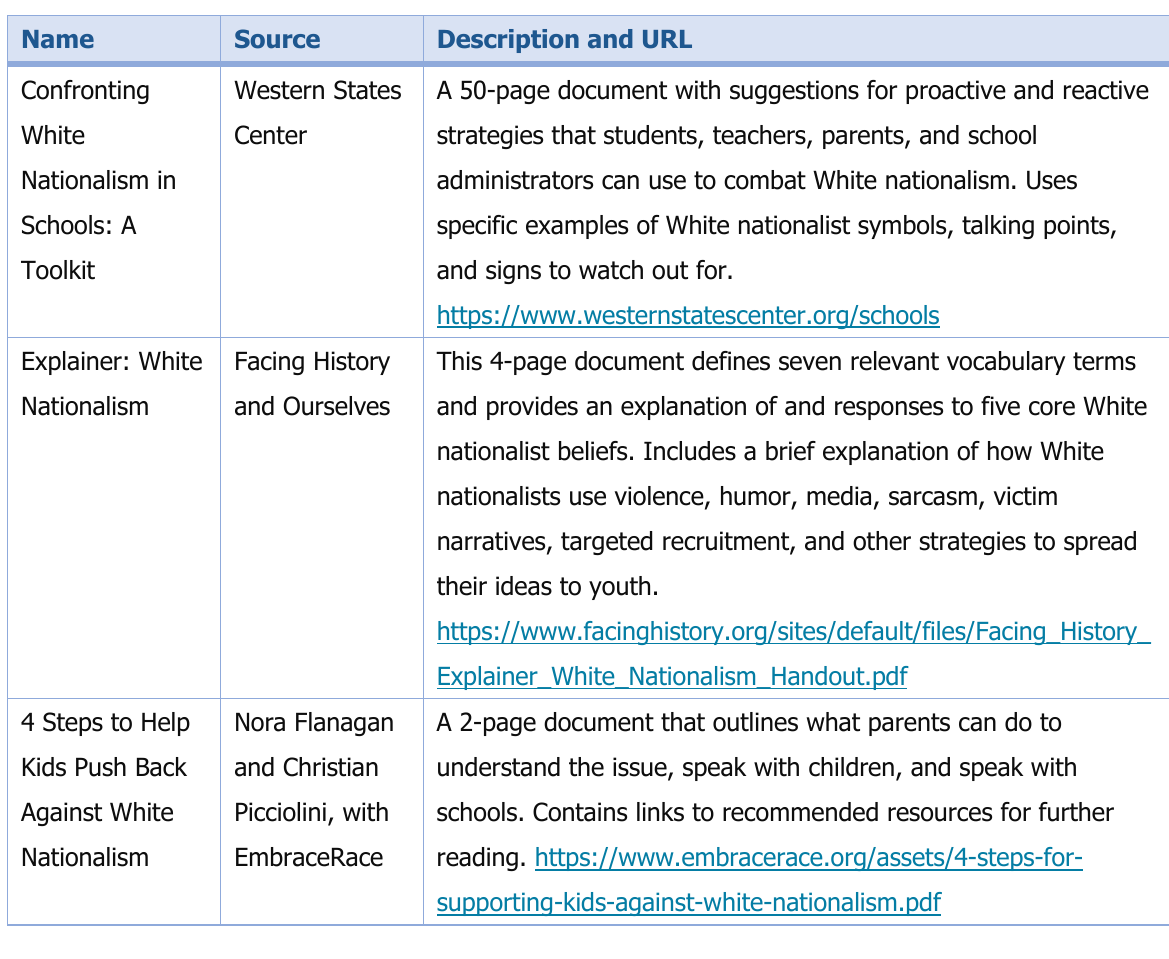
Table 4. Examples of Existing Resources for Supporting Youth in Resisting Fascist